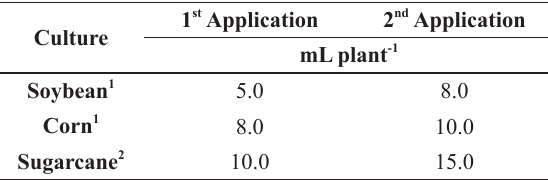
Amount of fungal suspension ( Beauveria bassiana, Metarhizium anisopliae, Pochonia chalamydosporia, Purpureocillium lilacinum , and Trichoderma asperella ) sprayed to the crops with a hand